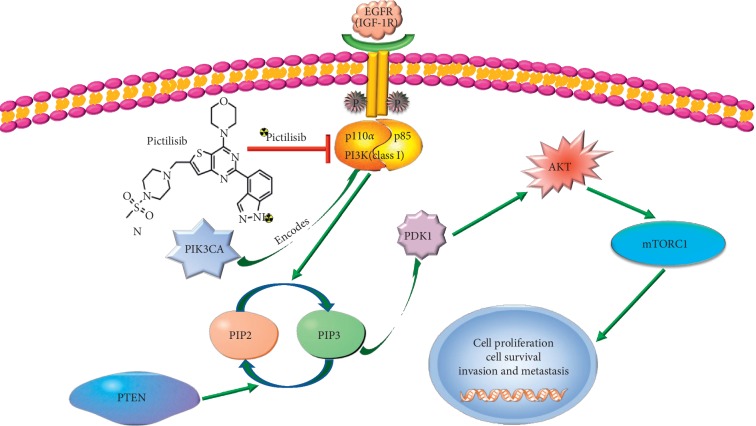
Overview of PI3K/AKT/mTOR signaling pathway and downstream effects. Pictilisib blocks the catalytic activity of PI3K class I isoforms. When pictilisib is labeled with radionuclides, this probe can target and monitor PI3K. Note: the red arrow indicates inhibition and the green arrow indicates promotion. EGFR: epithelial growth factor receptor; IGF-1R: insulin-like growth factor-1 receptor; PIP2: phosphatidylinositol-4,5-bisphosphate; PIP3: phosphatidylinositol-3,4,5-triphosphate; AKT: protein kinase B; mTOR: mammalian target of rapamycin; PTEN: tensin homologue deleted on chromosome 10; PIK3CA: phosphatidylinositol-4,5-bisphosphate 3-kinase catalytic subunit alpha.